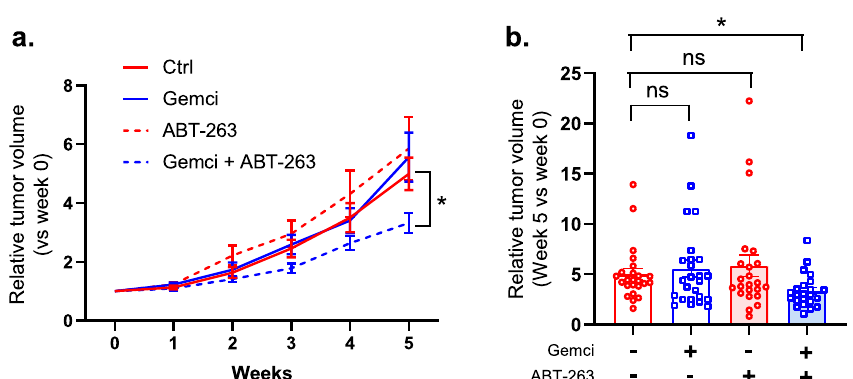
Fig. 6 ABT‑263 and gemcitabine inhibit tumor growth. After the subcutaneous injection of Panc1 cells, mice were randomized in 4 groups to obtain an average tumor size of 80 mm 3 before being treated with vehicles ( n